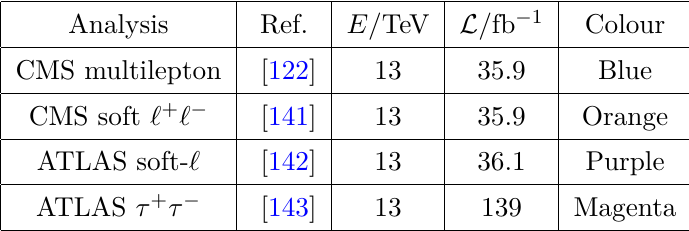
Table 5 . Analyses in CheckMATE which are relevant for GMSB scenario with NLSP different from